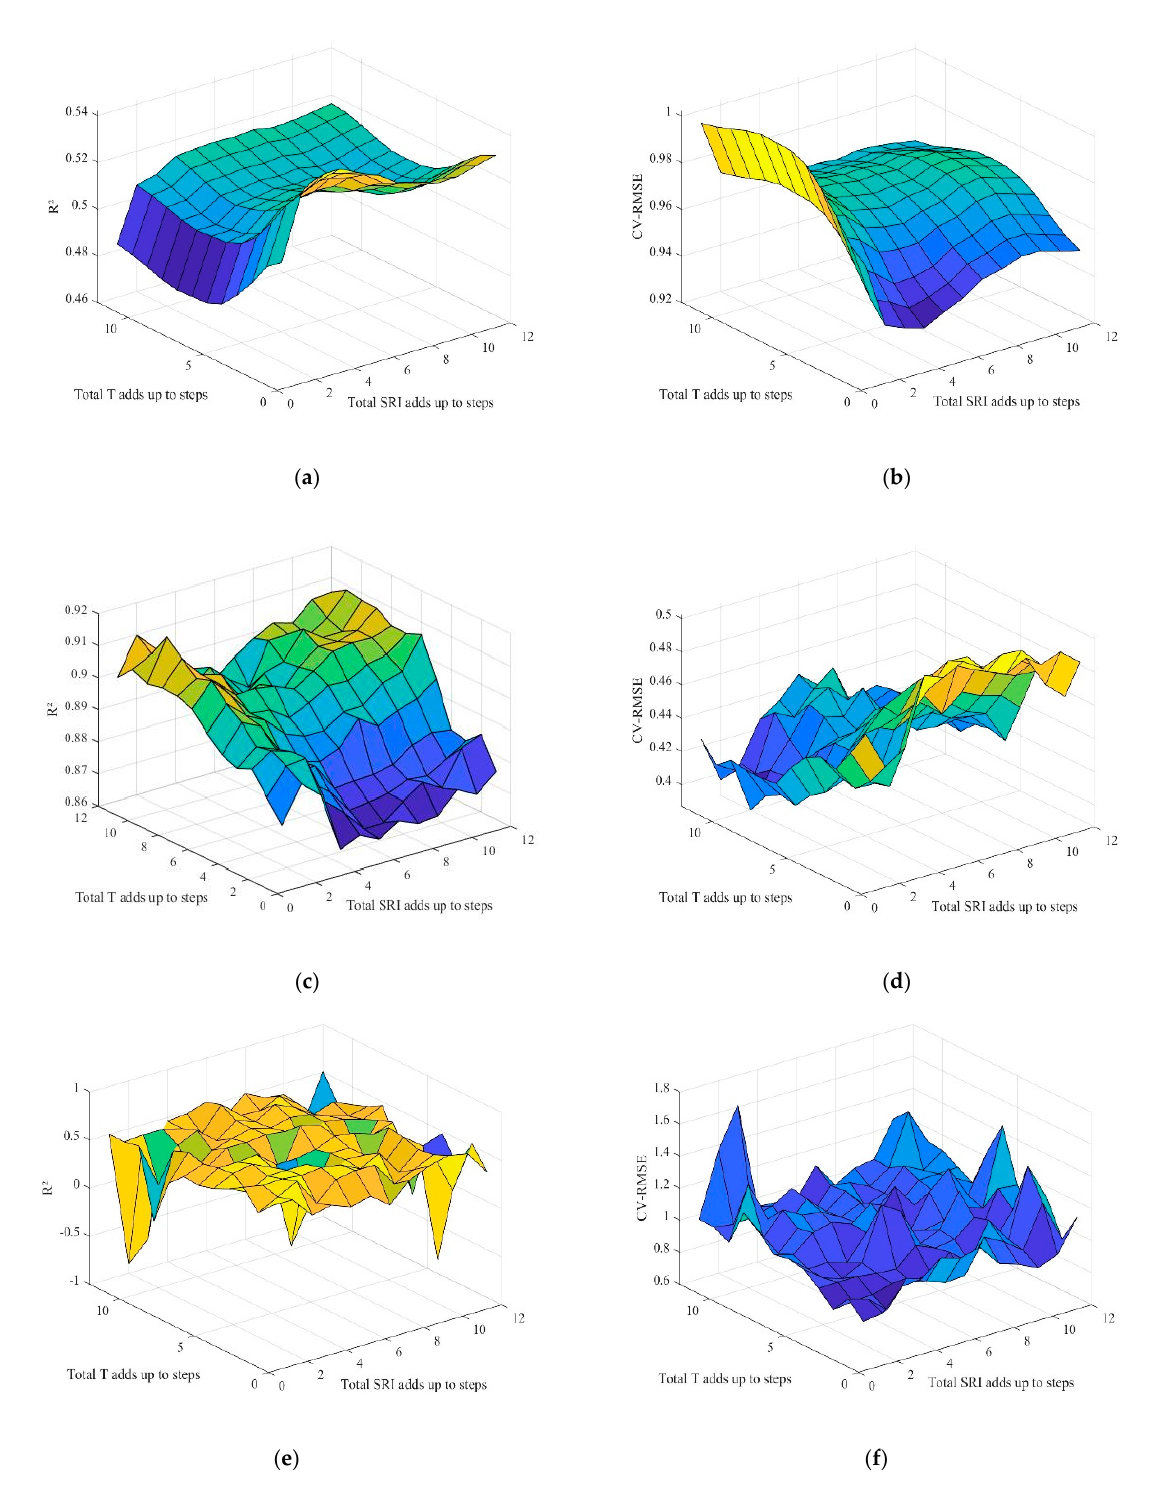
Figure 10. Accuracy index of Gaussian process regression model with the grid searching method. ( a ) R 2 (SVM). ( b ) CV-RMSE (SVM). ( c ) R 2 (RT). ( d ) CV-RMSE (RT). ( e ) R 2 (ANN). ( f ) CV-RMSE (ANN).